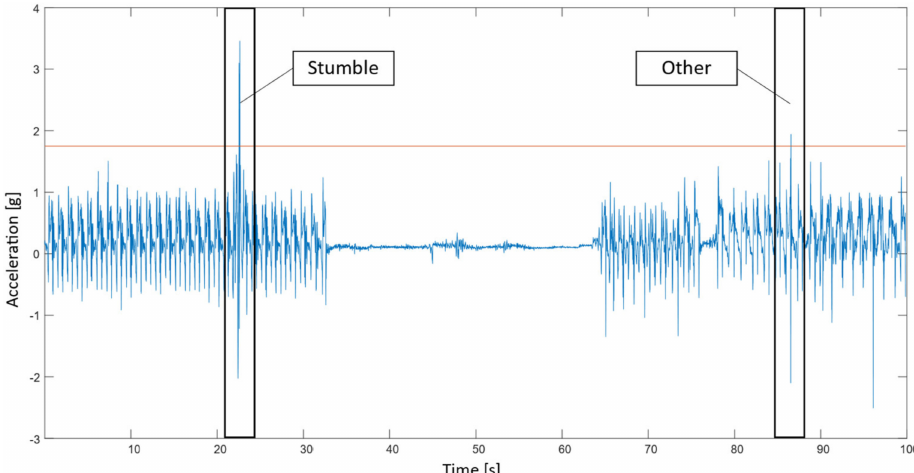
Figure 4. Event-defined window segmentation technique. Time windows were created around the intersection points between the accelerations in the (forward) z-direction (blue) and the threshold line